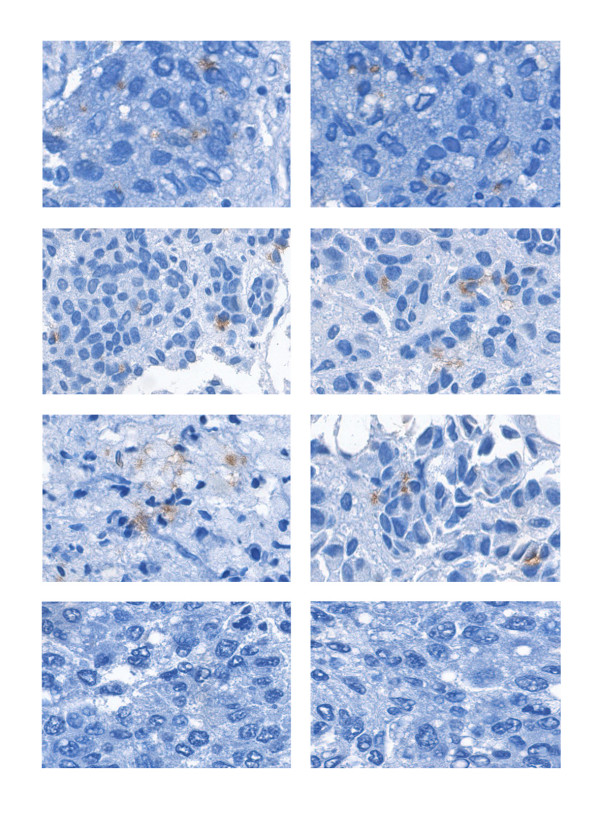
Immunohistochemistry analysis of CD133 expression in HCCs. CD133 was detected by avidin-biotin immunoperoxidase method. Nuclei were counterstained by hematoxylin. Original magnification, 400×. Two HCC samples negative for CD133 expression served as negative controls (bottom panel).